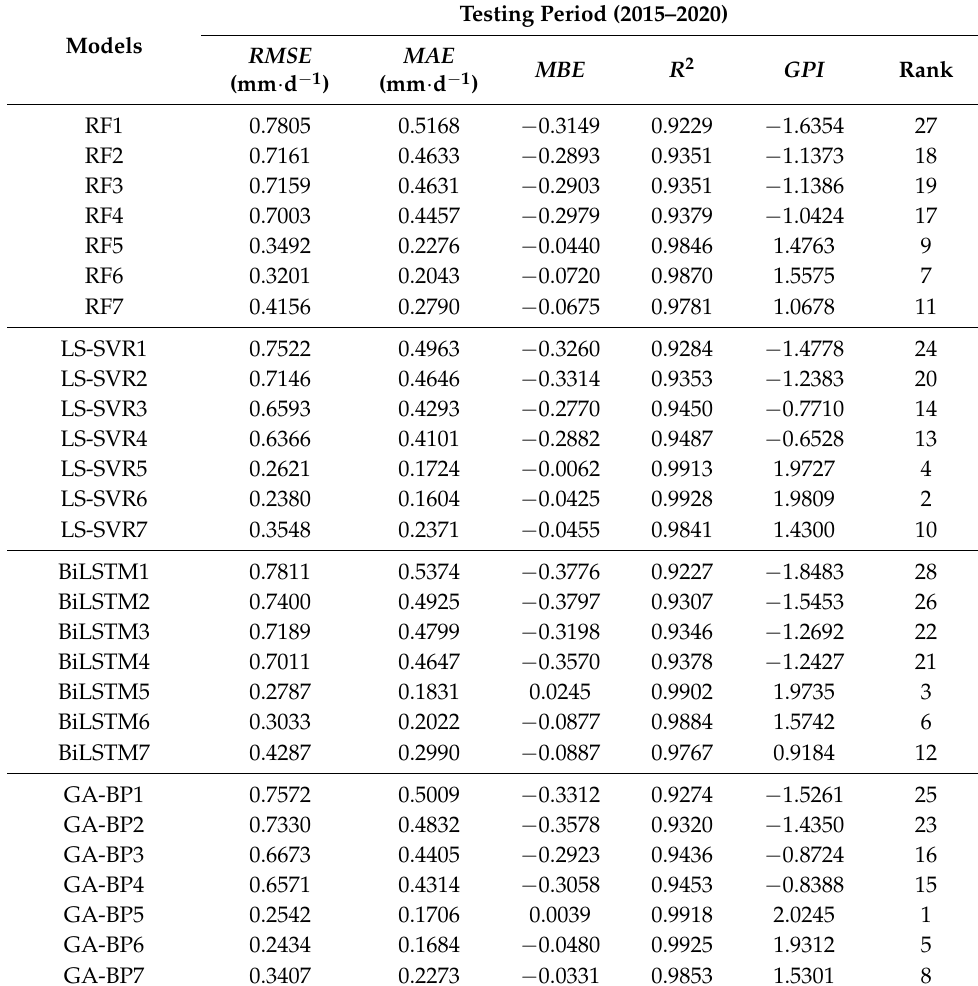
Table 5. Performance of RF, LS-SV, Bi-LSTM and GA-BP models during the testing